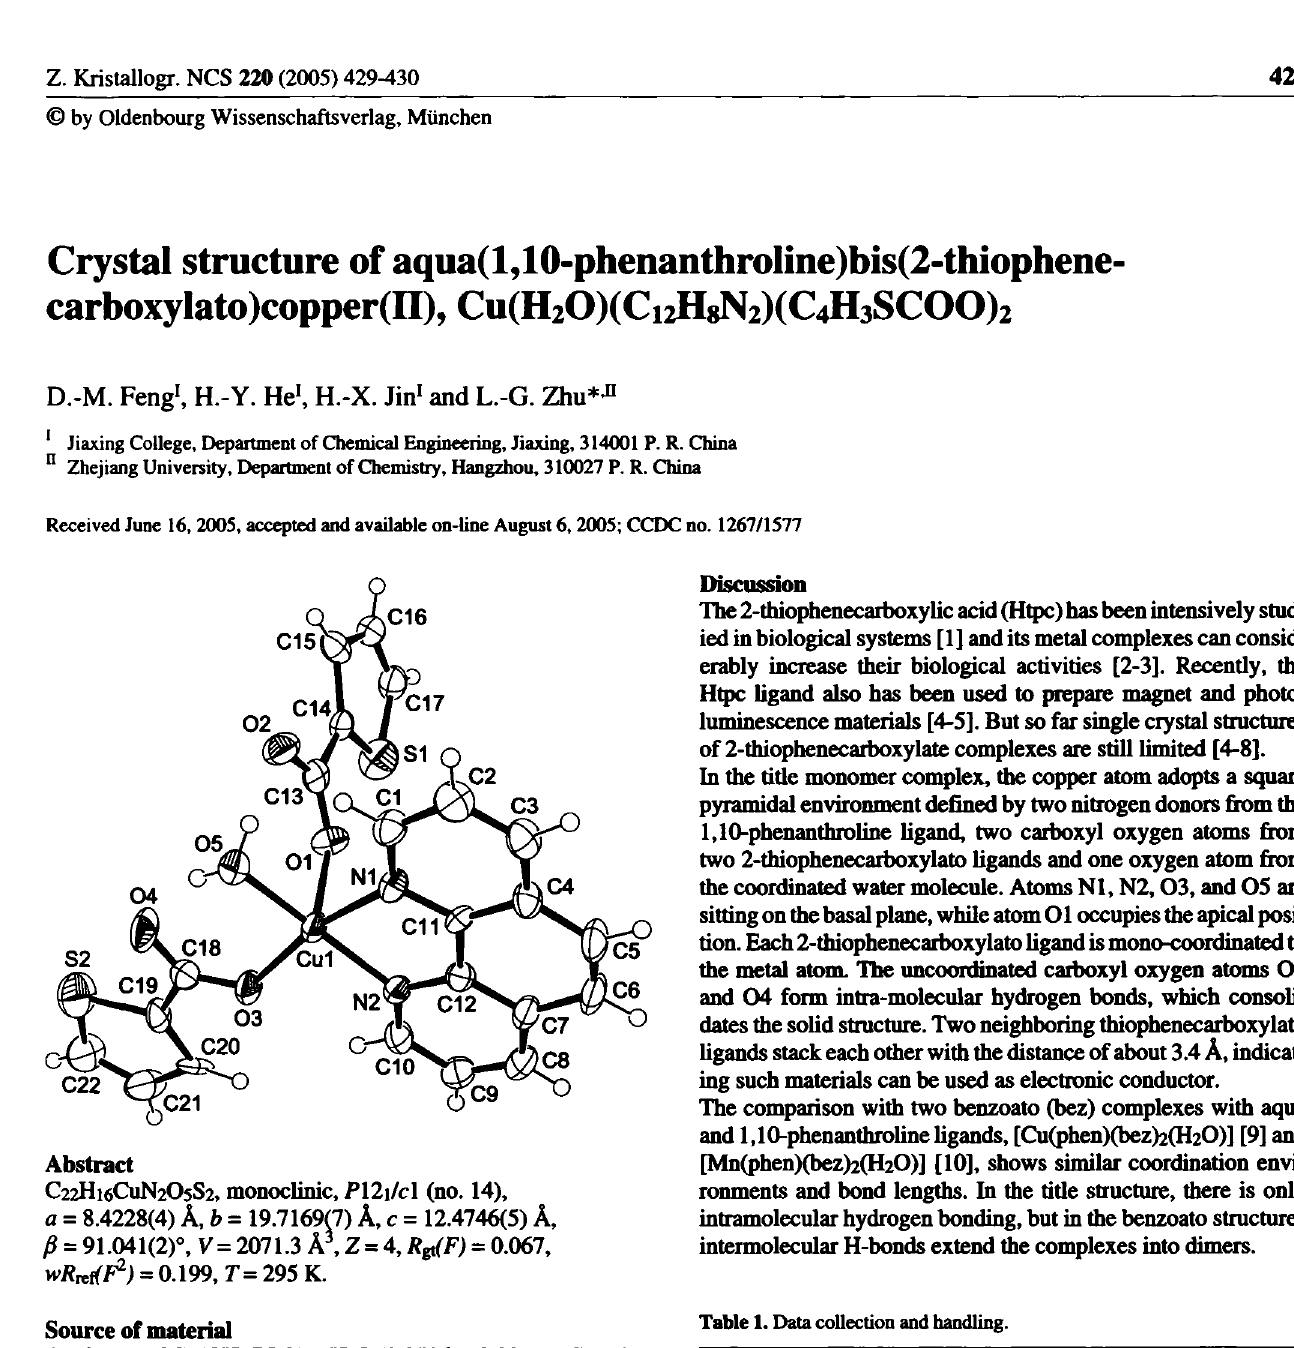
Table 1. Data collection and handling.